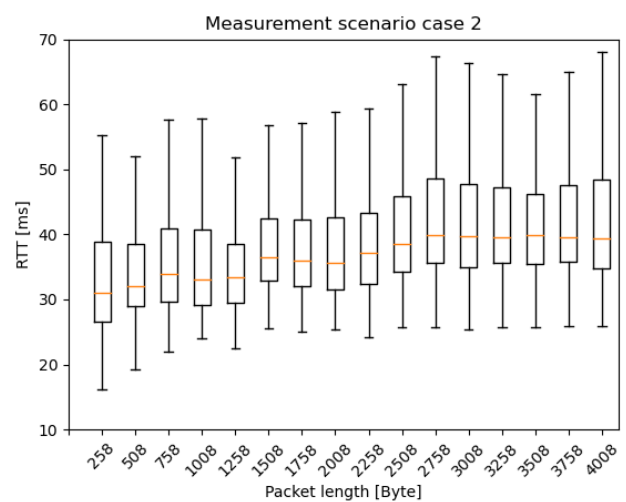
Figure 14. RTT results with different packet lengths scenario 2: from 10 ms IAT and 250 Byte PL, to 310 ms IAT and 4000 Byte PL, increment the PL by 250 Byte for every iteration and the IAT by 100 ms for every fourth iteration.